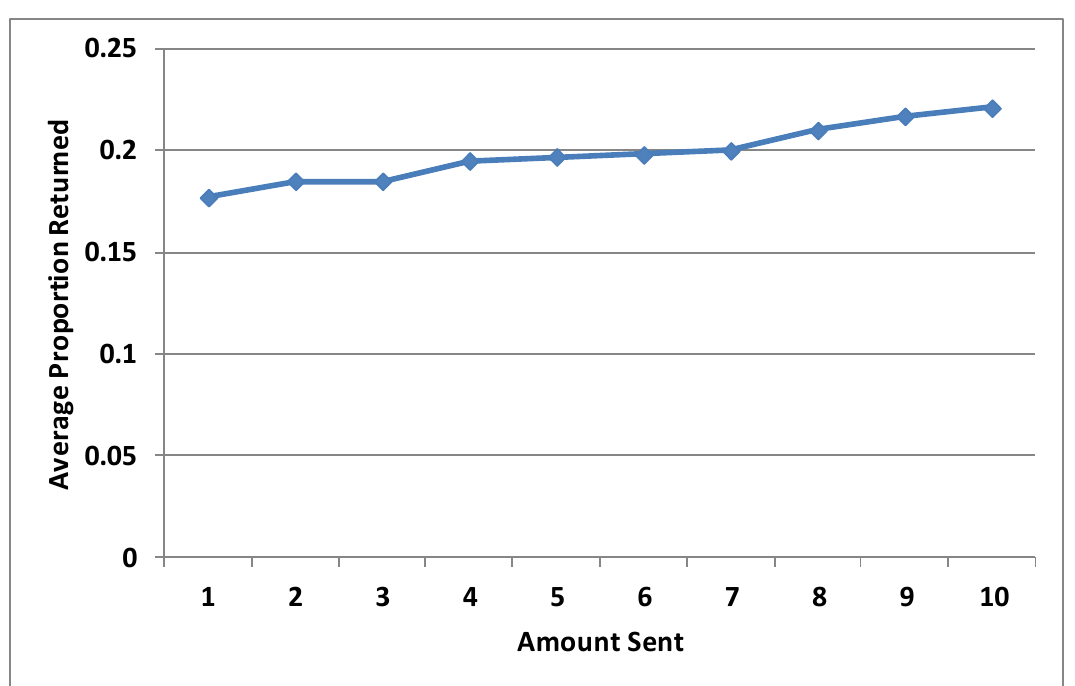
Figure 1. Average proportion returned for each amount